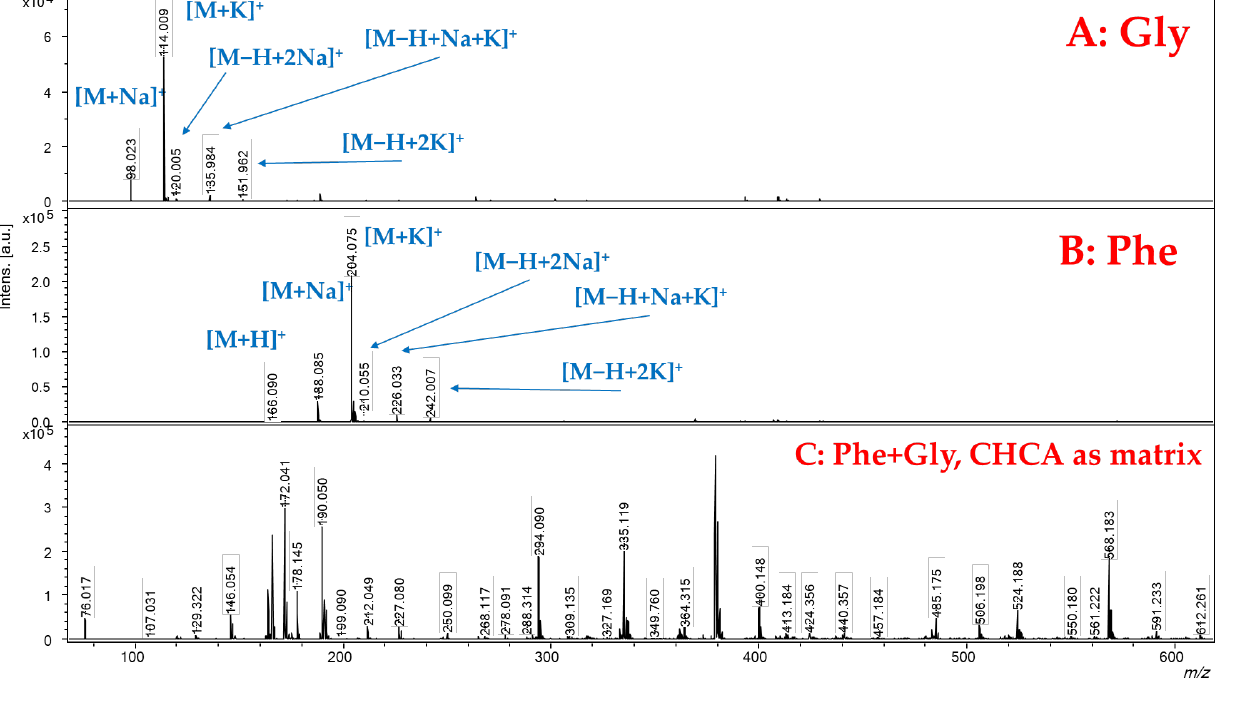
Figure 2. SALDI-MS spectra, obtained in positive ionization mode, for the analysis of ( A ): glycine (water solution, 1 mg/mL) and ( B ): phenylalanine (water solution, 1 mg/mL). ( C ): Spectrum in MALDI condition using CHCA as matrix, in positive ionization mode, for the analysis of Gly and Phe (water solution, 1 mg/mL each).